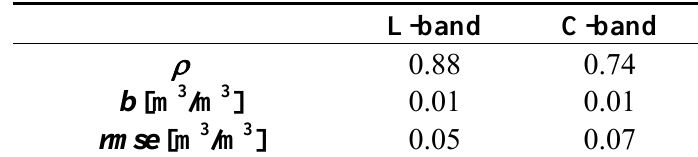
Table 6. Results of the comparison between the soil moistures belonging to the test sets (500 records) and those estimated by using NNs in the retrieval algorithm built for fixed  i based on